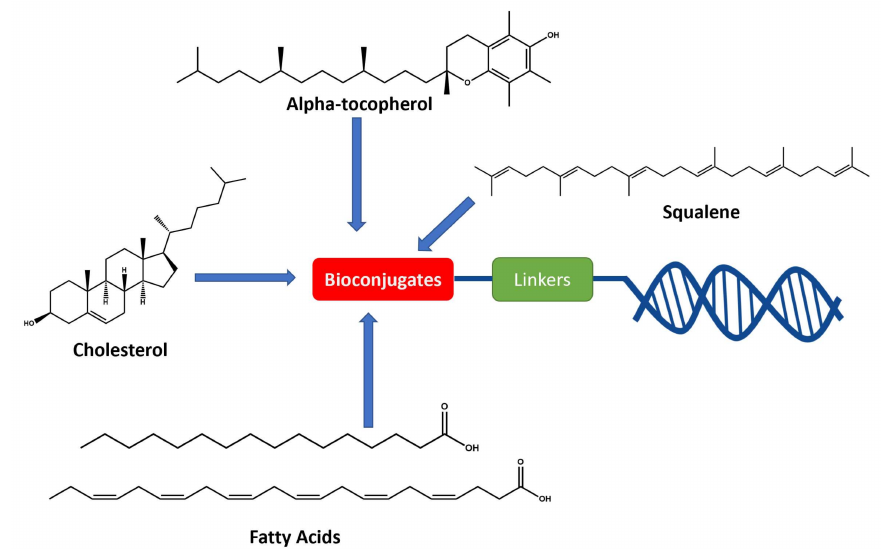
Figure 6. General molecular structure of conjugated oligonucleotides including: (1) synthetic oligonu- cleotide, (2) linkers, and (3)